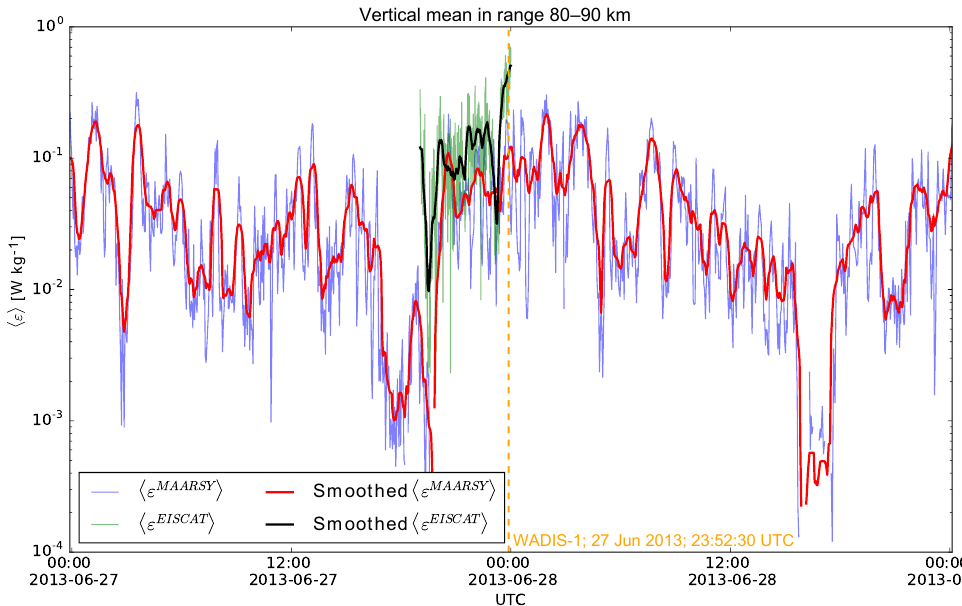
Figure 17. Vertical mean over altitude range 80–90km of radar turbulence measurements. Blue and green are MAARSY and EISCAT measurements with full time resolution. Bold red and black lines were derived as running means of the blue and green profiles for MAARSY and EISCAT, respectively.